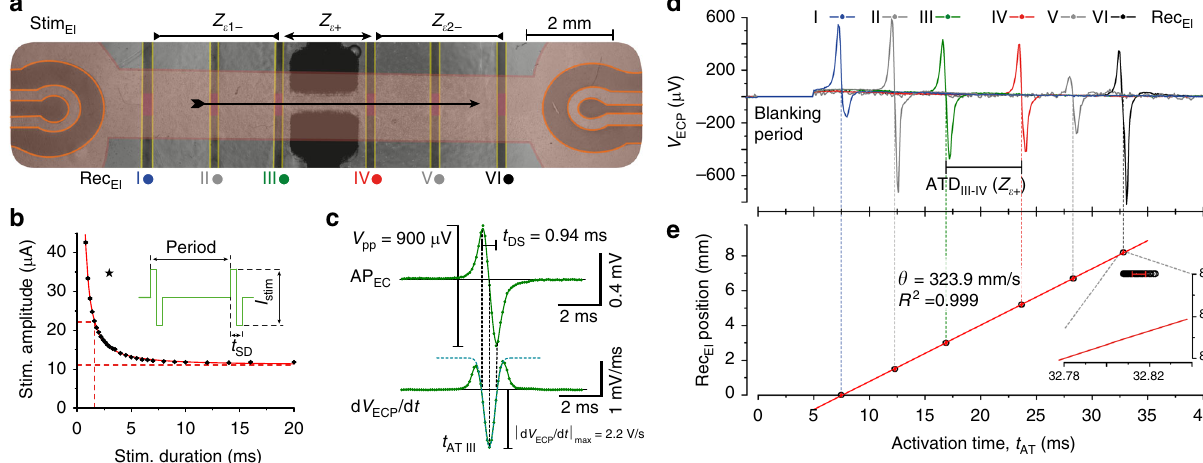
Fig. 3 Stimulation and recording with fl exible gold ion-implanted electrodes. a Composite image of a cell strand (red) with stimulation (orange) and recording electrodes (yellow) on either side of the DEA electrodes (black). The center arrow illustrates the direction of action potential propagation. b Strength – duration curve for stimulation of the preparation with bi-polar current pulses (inset). The star indicates typical stimulation parameters used during the experiments. c Upper panel: AP EC as recorded by one electrode during propagated electrical activity along the cell strand. The AP EC exhibits an amplitude ( V pp ) of 900 µ V and, as calculated from the Gaussian fi t to the fi rst derivative (lower panel), a downstroke time ( t DS ) of 940 ms and a maximal downstroke velocity of − 2.2 V s − 1 . The negative peak of the fi t was used to determine the local activation time ( t AT ). d AP ECs recorded by all electrodes during propagated electrical activity. The initial 5 ms of the signals containing the stimulation artifact were blanked. e Plot of local activation times vs. position for each recording electrode. Conduction velocity ( θ = 324 mm s − 1 ) is derived from the slope of a linear fi t to the data. The insert indicates the presence of minimal t AT variability (SD < 10 μ s, n = 170 serial stimulations) at Rec El III during 170 successive